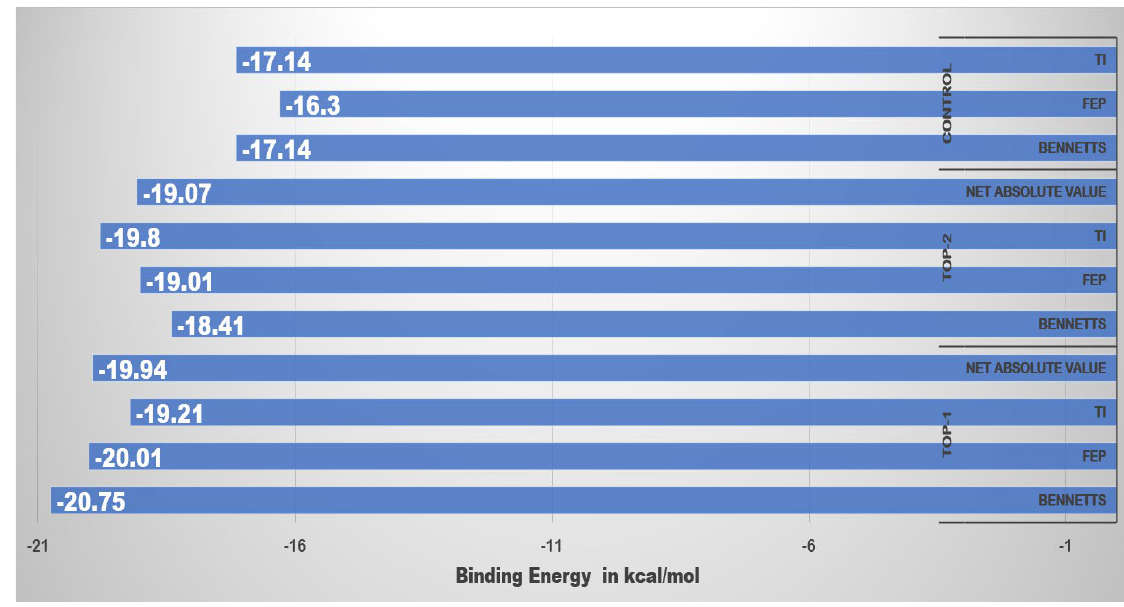
Figure 5. WaterSwap binding free energies are estimated by different methods such TI, FEP, and BENNETTS. The energy values are given in kcal/mol.